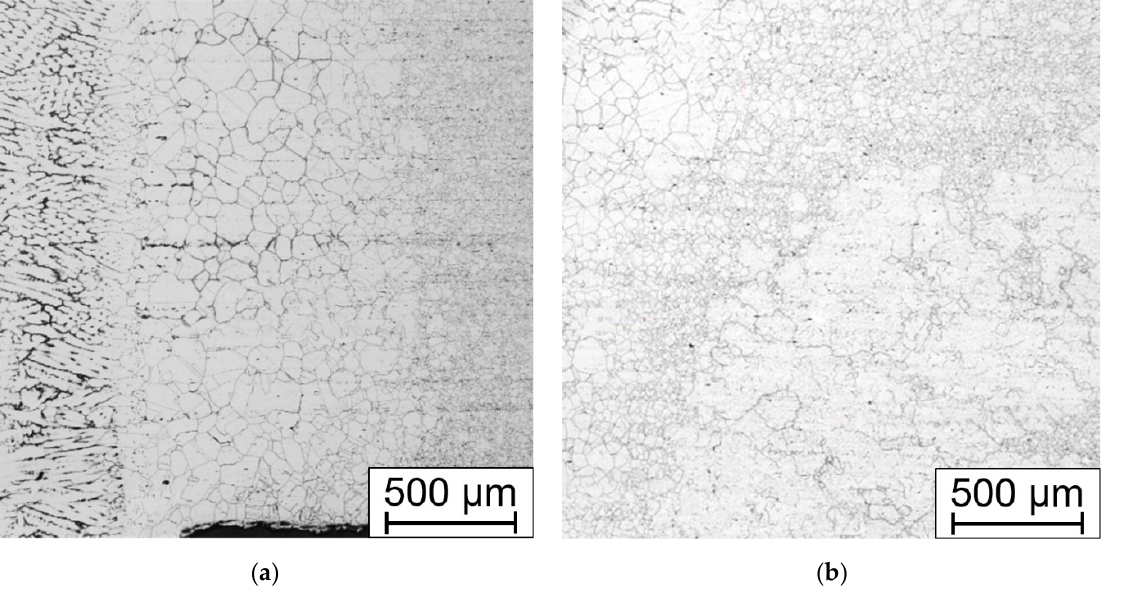
Figure 18. Root of the weld ( a ) without HT; ( b ) after HT with coarse grain areas close to the HAZ on the left. Electrolytically etched in 10% aqueous acetic acid (5 V DC, 10 s).